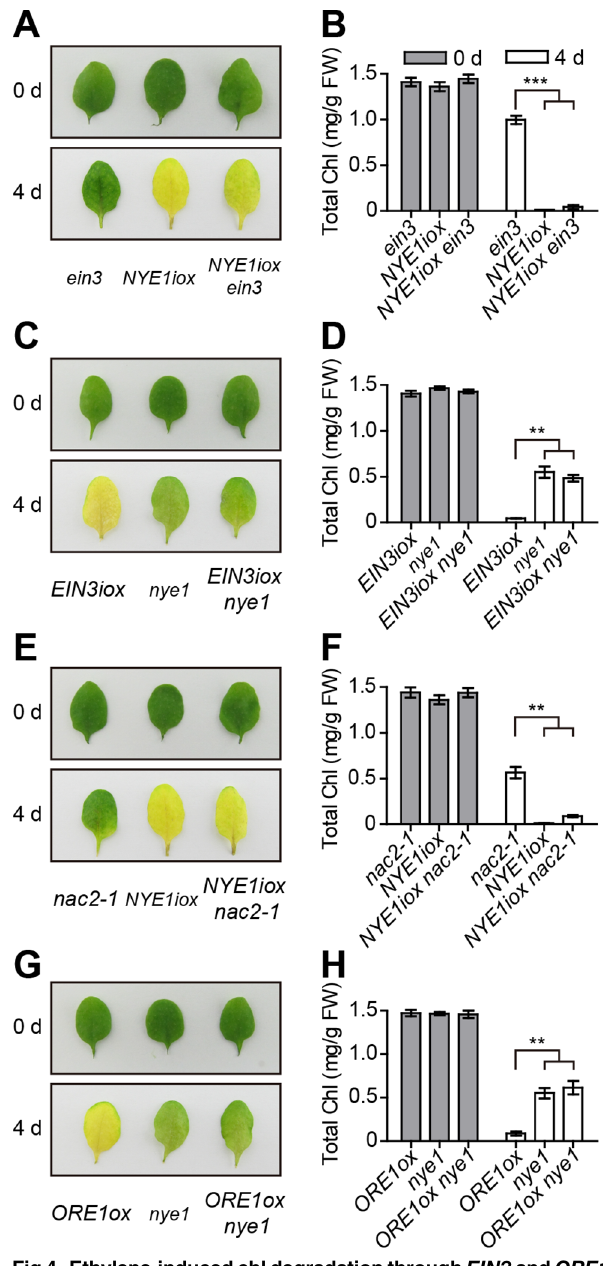
Fig 4. Ethylene-induced chl degradation through EIN3 and ORE1 is NYE1 -dependent. (A) Inducible overexpression of NYE1 reversed the stay-green phenotype of e in3 mutant under ethylene treatment. The dexamethasone (DEX)-inducible NYE1 line ( NYE1iox ) was crossed with ein3 to obtain NYE1iox ein3 . The leaves of each indicated genotype were sprayed with 15 μ mol/L DEX to induce NYE1 expression and underwent ethylene treatment for 4 d. (B) Quantification of total chl content in leaves of each indicated genotype and time point shown in (A). (C) The loss-of-function nye1 mutant repressed chl degradation of the inducible overexpression of EIN3 transgenic line during ethylene-induced senescence. The estradiol (EST)- inducible EIN3 line EIN3iox was crossed with nye1 to obtain EIN3iox nye1 . Leaves were sprayed with 100 μ mol/L EST to induce EIN3 expression and underwent ethylene treatments for 4 d. (D) Quantification of total chl content in leaves of each indicated genotype and time point shown in (C). (E) Inducible overexpression of NYE1 reversed the stay-green phenotype of nac2-1 mutant under ethylene treatment. The DEX-inducible NYE1 line ( NYE1iox ) was crossed with nac2-1 mutant to obtain NYE1iox nac2-1 . The treatments were as in (A) except for different plant genotypes. (F) Quantitative analysis of total chl content in leaves of each indicated genotype and time point shown in (E). (G) The loss-of-function nye1